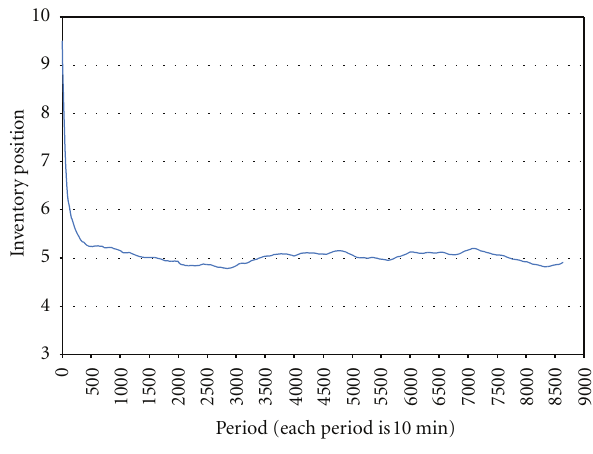
Figure 5: Determining warmup period. Table 1: Empirical distribution of customer’s demand size.